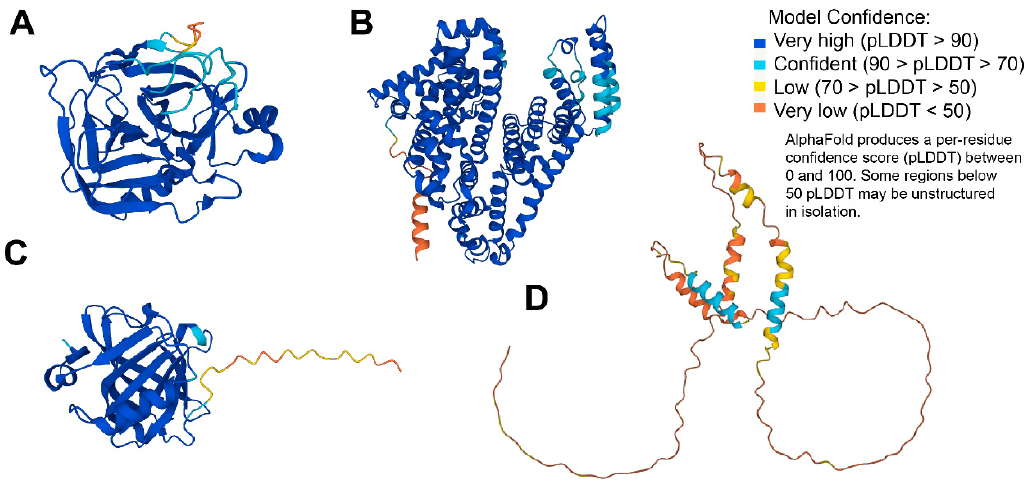
Figure 3. 3D structures modeled for the discussed proteins by AlphaFold [88]: ( A ) α –chymotrypsin (UniProt ID: P00766); ( B ) human serum albumin (UniProt ID: P02768); ( C ) β -lactoglobulin (UniProt ID: P02754); ( D ) α -casein (UniProt ID: P02662).